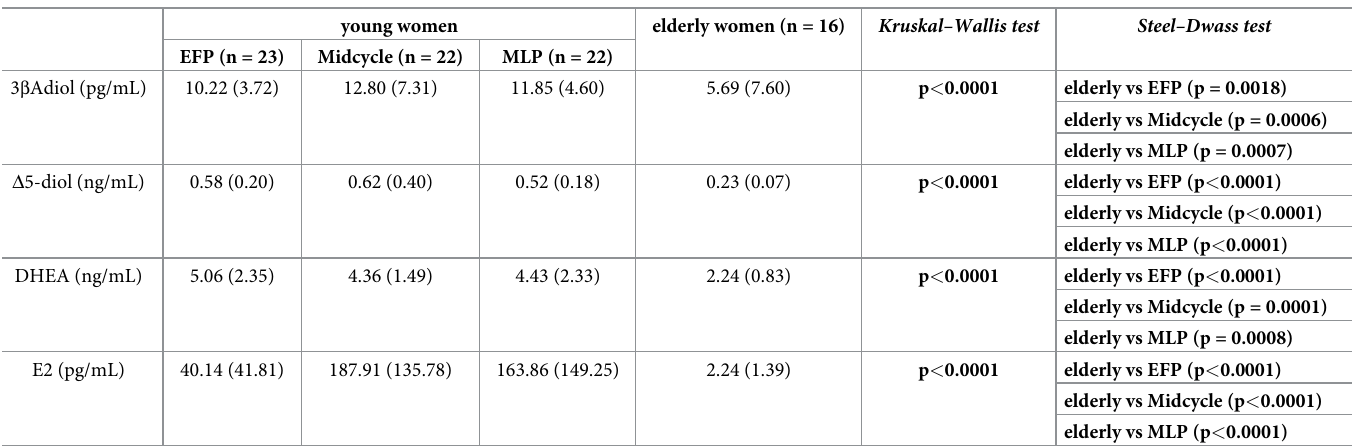
Table 6. Comparison of steroid levels between young women and elderly